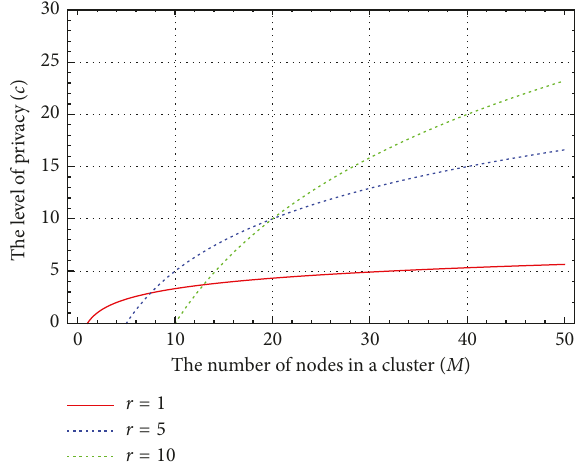
Figure 3: The different number of nodes in a